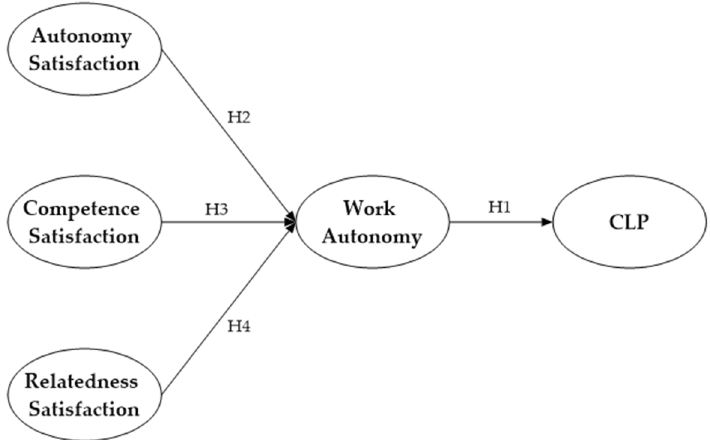
Figure 1. Research model.